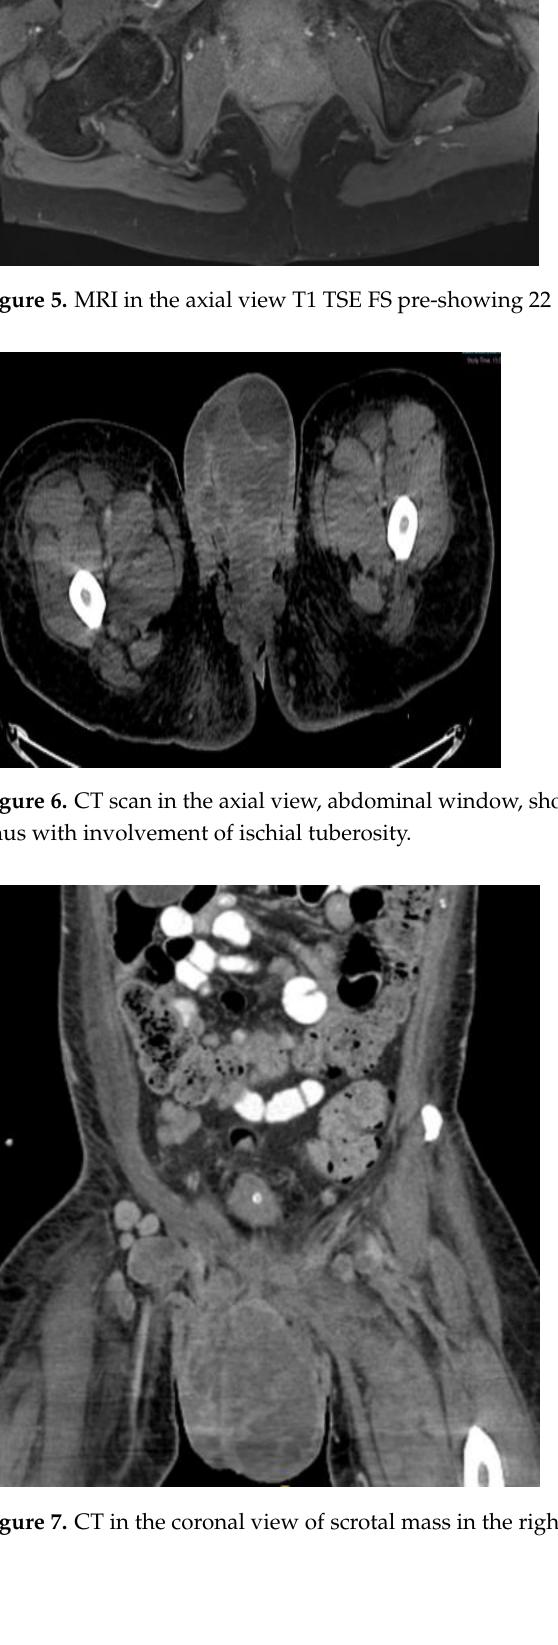
Figure 8. CT in the sagittal view, abdominal window, showing scrotal mass extending to erect penis.